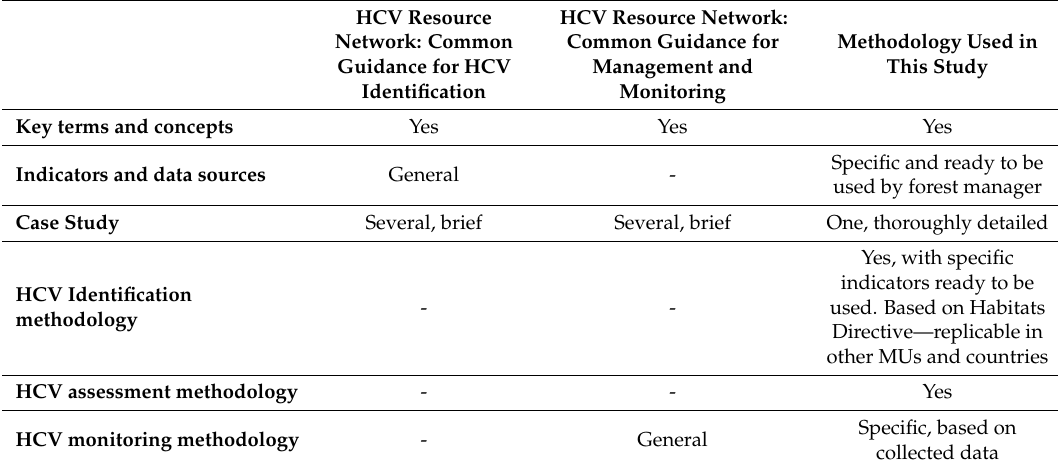
Figure 2. Digital orthophotograph of PNOA (Plan Nacional de Ortofotografía Aérea) with the shapefile of the Forest Management Unit (FMU) “ Los Barrancos ,” located in the municipality of Aracena (Nature Park of Sierra de Aracena, Huelva, Spain). The polygons correspond to conservation areas of natural or semi natural vegetation. These areas are typically in a matrix of eucalyptus plantation, usually arranged into terraces, for logging purposes. Table 2. Comparison between the methodology used in this study and the guidelines from the HCV Resource Network in terms of identification, assessment and monitoring steps.